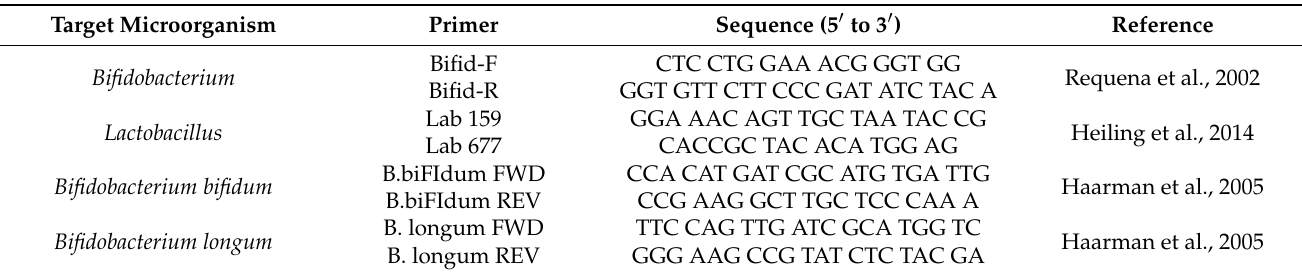
Table 1. Primers used for the detection of genera Bifidobacterium spp., Lactobacillus spp., and Bifidobacterium bifidum and Bifidobacterium longum